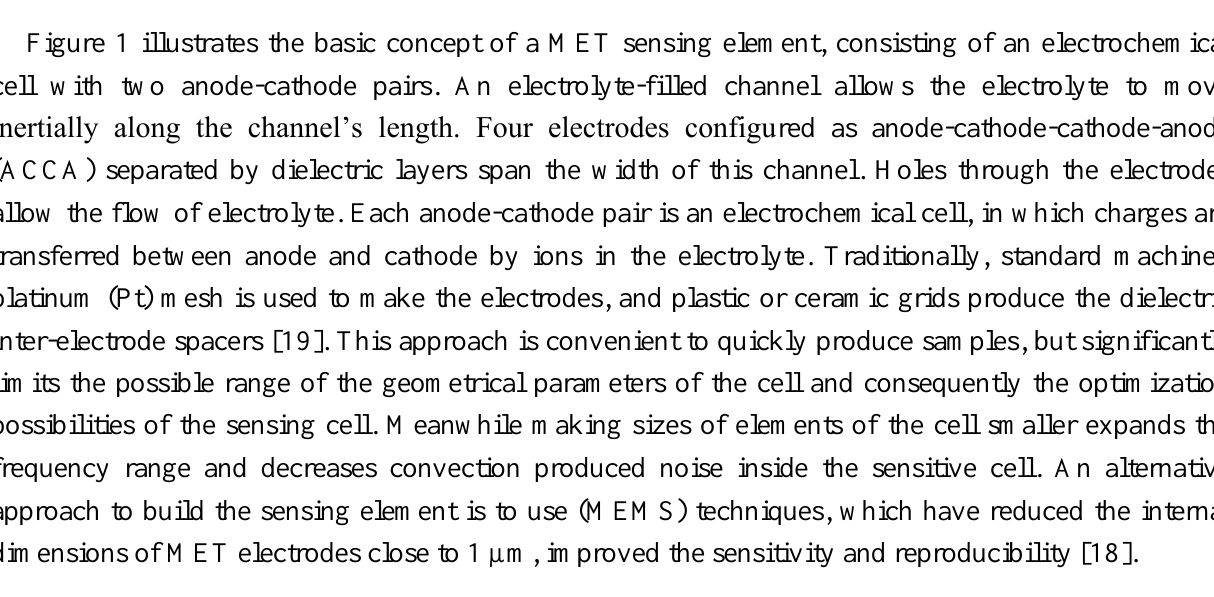
Figure 1. Schematic of the basic MET sensing